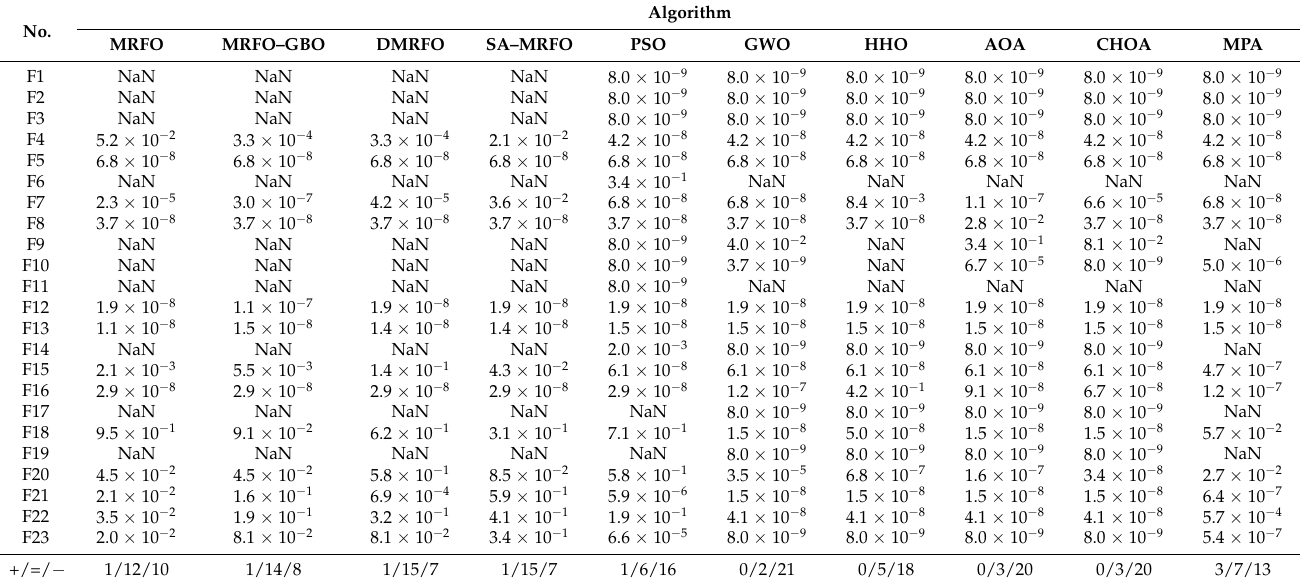
Table 7. Statistical results of each algorithm based on the